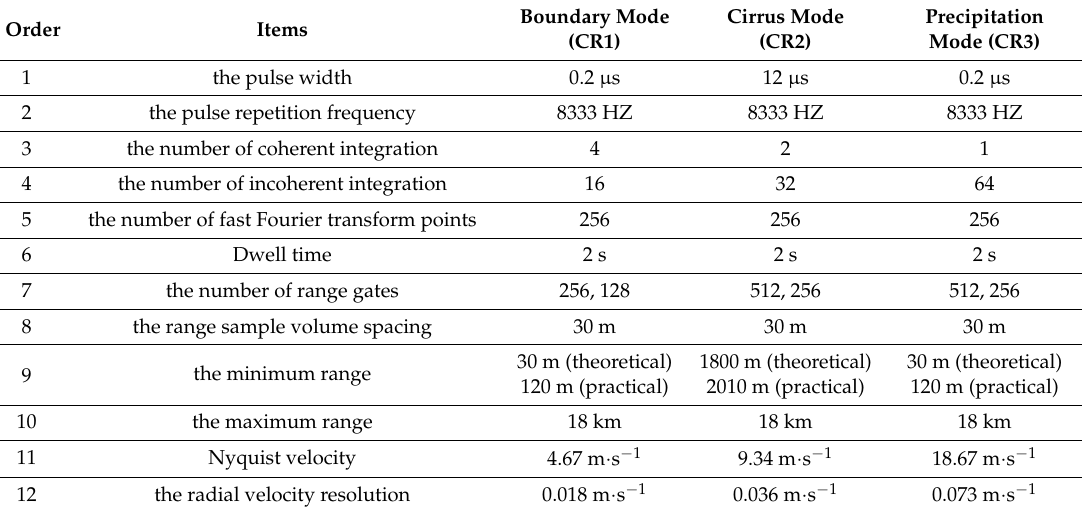
Table 2. Major operational parameters for the three operational